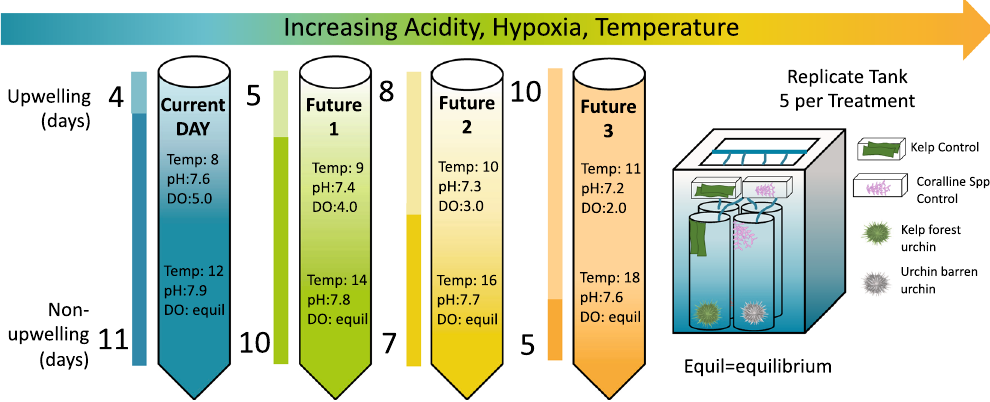
Figure 5. Schematic of experimental design and treatment description for the mesocosm experiment. Seawater chemistry parameters for each upwelling severity treatment are (L-R): reservoir 1—Current Day (blue), reservoir 2—Future 1 (green), reservoir 3—Future 2 (yellow), reservoir 4—Future 3 (orange). Both upwelling and non-upwelling event conditions regarding seawater parameters are listed in each corresponding reservoir, with upwelling on top and non-upwelling on the bottom. Colored bars located on the left side of each reservoir represent the duration of each upwelling and non-upwelling event in days. Lighter colors represent upwelling, and darker colors represent non-upwelling. Each reservoir delivered treated water to five randomly distributed replicate tanks. Each replicate tank housed four columns, each with one sea urchin, for a total of two kelp forest urchins and two urchin barren urchins (n = 10 urchins per treatment combination). The individual urchins in each column were completely separate from one another and could not interact physically, though the columns were perforated allowing treated water in each tank to intermingle among columns. See figure key for additional components of each replicate